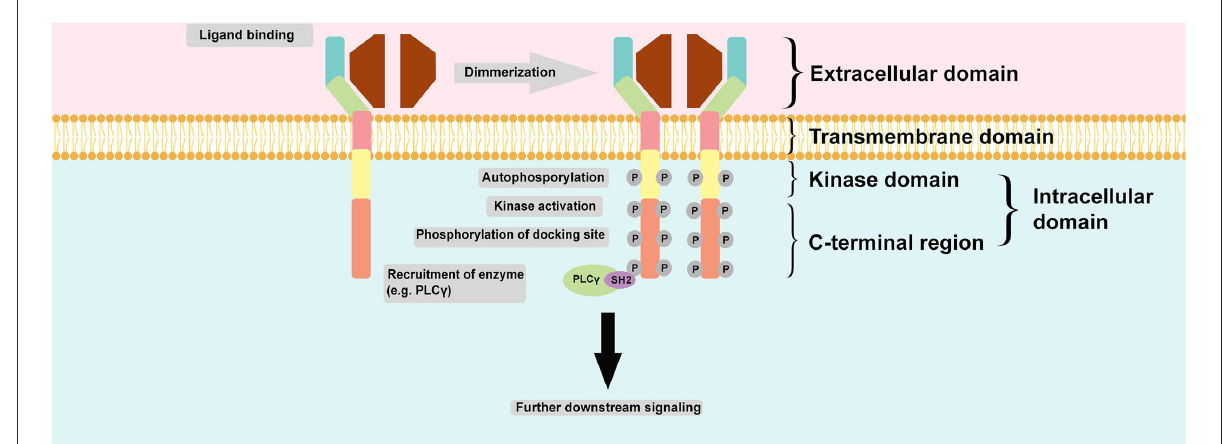
FIGURE2 Common structure of RTK and its mechanism of activation and signaling. RTK is structurally composed of an extracellular domain which interacts with its ligand and distinguishes it from NRTK; an anchoring transmembrane domain; and an intracellular domain which composed of kinase domain and C-terminal region. Commonly, two monomeric RTKs are dimerized upon ligand binding leading autophosphorylation and subsequent tyrosine kinase activity stimulation and finally phosphorylation of docking site within the C-terminal region of intracellular domain for docking with another enzyme, such as PLC γ . The final action is further downstream signaling